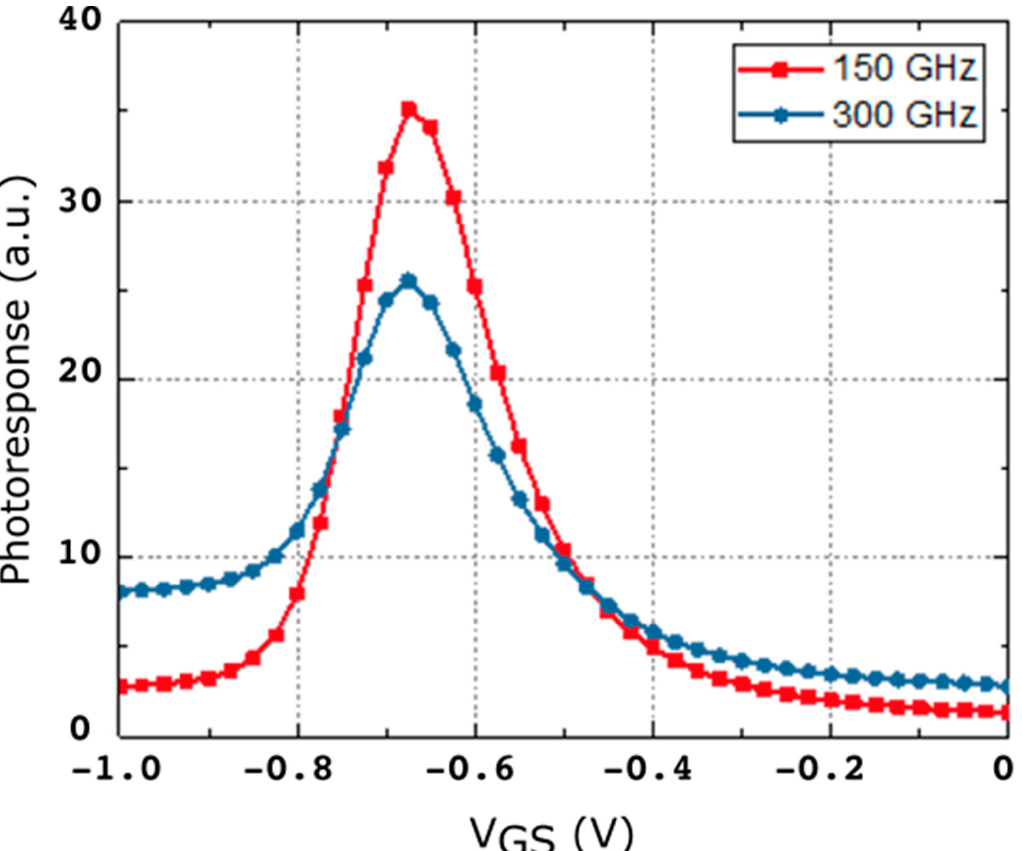
Figure 4. Photoresponse signal vs. gate voltage under front excitation of 0.15 THz (red symbols) and 0.3 THz (blue symbols).